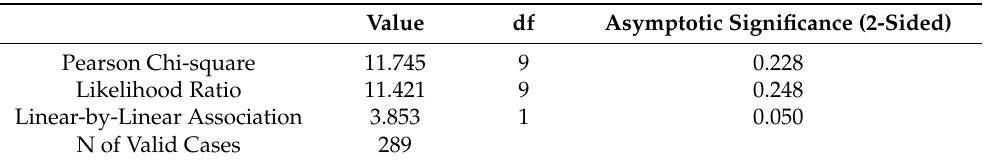
Table 11. Chi-square tests on the correlation between respondents’ experience and the appreciation of the opportunity to allocate funds for the digitization of financial accounting activity. Value